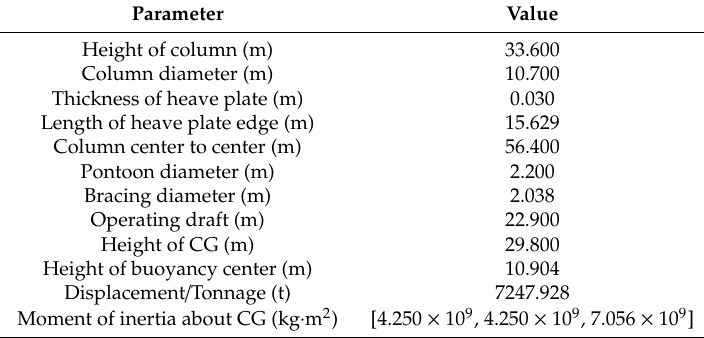
Table 1. Main Parameters of the WindFloat-type platform-type platform.